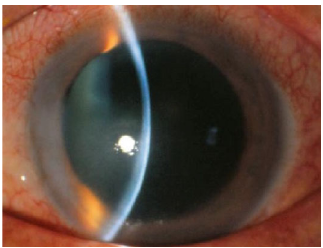
Figure 1: Slit-lamp photographs of the patient ’ s left eye. Six years before the fi rst visit, a portion of his cornea became slightly thin and developed a scar in the paracentral cornea after an episode of herpes simplex